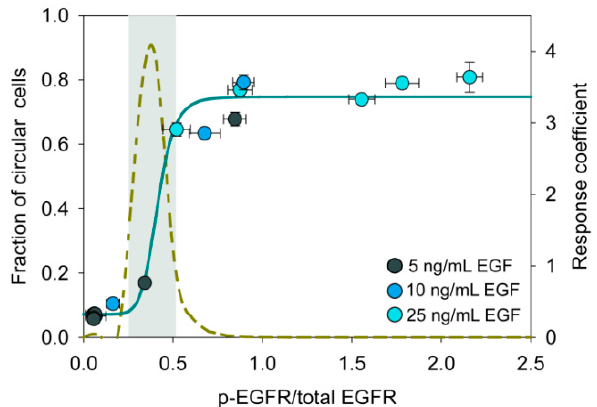
Figure 6. Ultrasensitive switch-like response during state transition. The plot shows the relation between the fraction of cells in circular state and phosphorylation of EGFR. Normalized level of phospho-EGFR was estimated by densitometry of Western blot images. Data were fitted to the Hill function (Hill coefficient t = 8.6). Ultrasensitive systems have a Hill coefficient greater than one. The dashed line represents the response coefficient [53]. The gray shaded region represents the ultrasensitive region where the response coefficient is greater than 1.